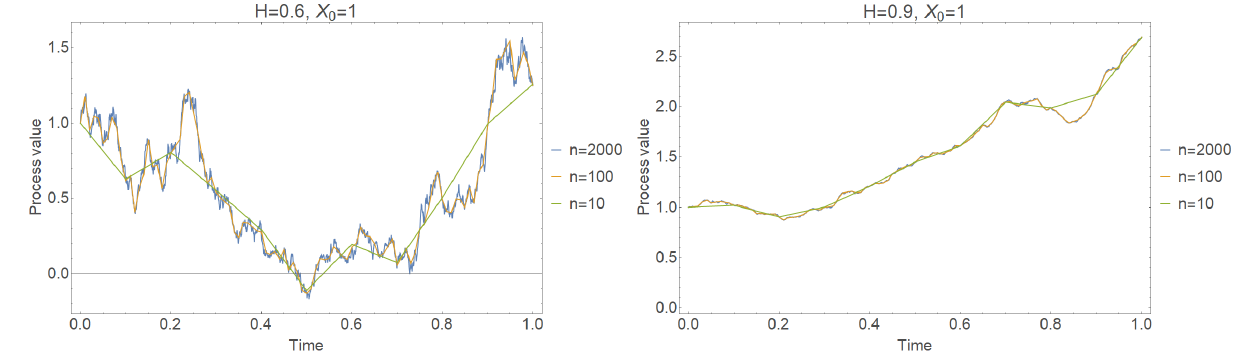
Figure 1. Approximation trajectories of Pearson process for conditions (19).